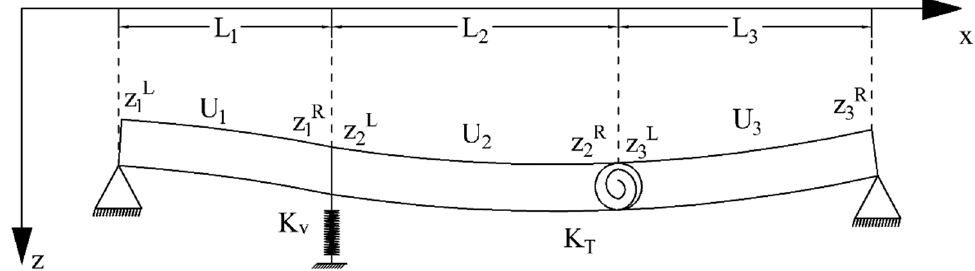
Figure 2. Simply supported beam with discontinuities at stations 𝐿 (cid:2869) and 𝐿 (cid:2870)